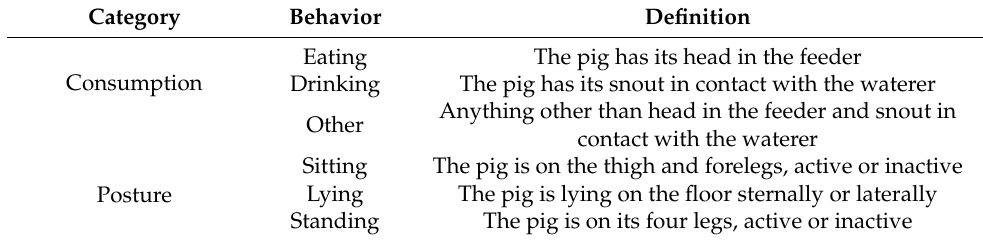
Table 1. Ethogram used for behavior